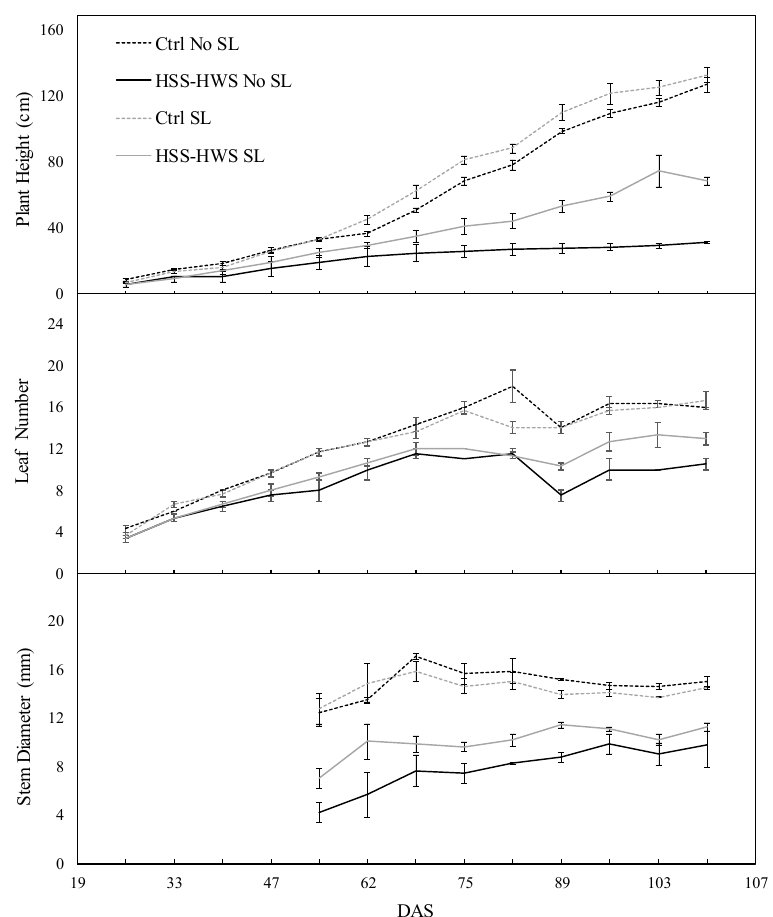
Figure 1. Time trend of sorghum morphological traits in four treatments at variable soil and water salinity and salt leaching. Ctrl, control; HSS-HWS, high soil salinity and high water salinity; SL, salt leaching; DAS, days after seeding. Vertical bars indicate ± standard error (n = 3).